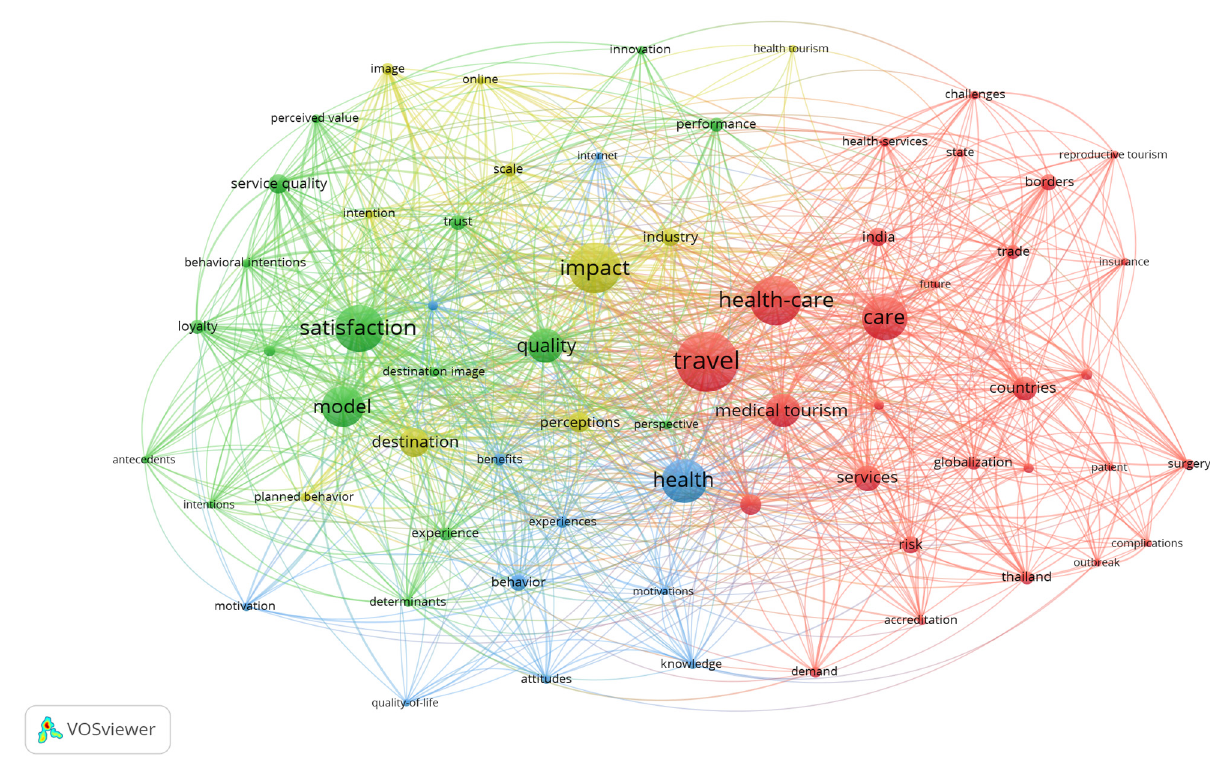
Figure 3. Co-Word Cluster Map. Source: own elaboration based on the dedicated database. Cluster 1 (green): patient satisfaction built upon trust; Cluster 2 (yellow): health im- pacts of the destination; Cluster 3 (blue): health behavior as a major part of human activity; and Cluster 4 (red): traveling with a view to regain one’s health.